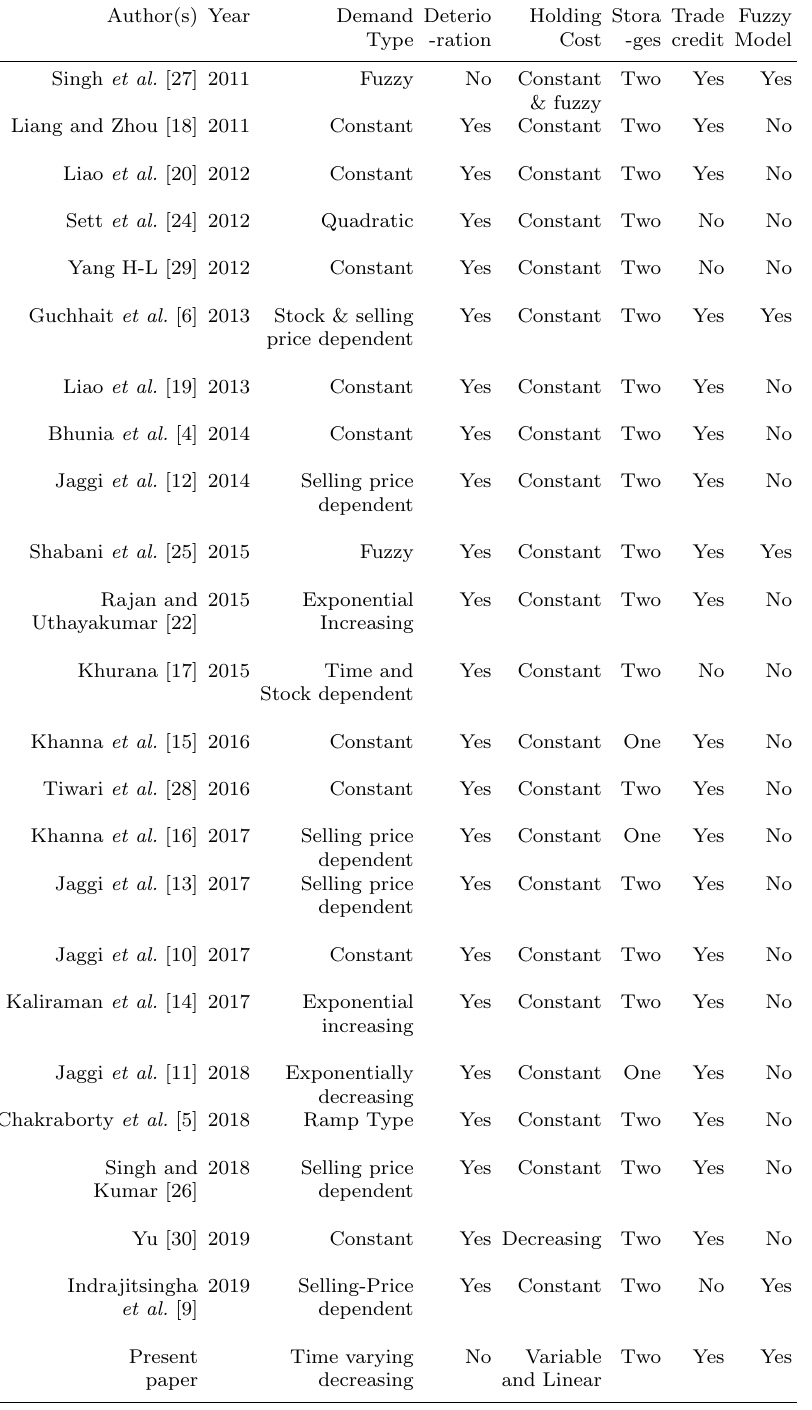
Table 1. Major characteristics of recent inventory models discussed in the